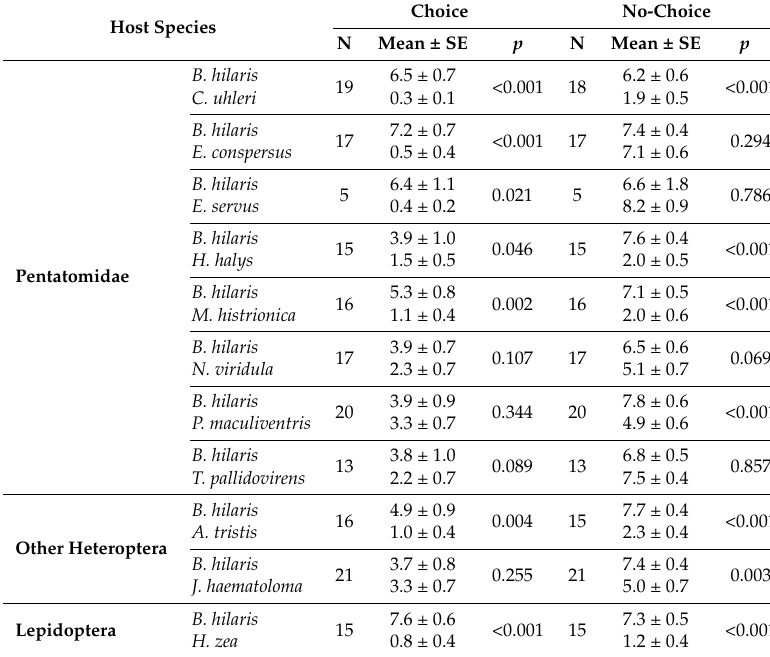
Table 2. Mean ( ± SE) number of Ooencyrtus mirus eggs (pedicels) laid within 24 h on 10 host eggs. Host Species